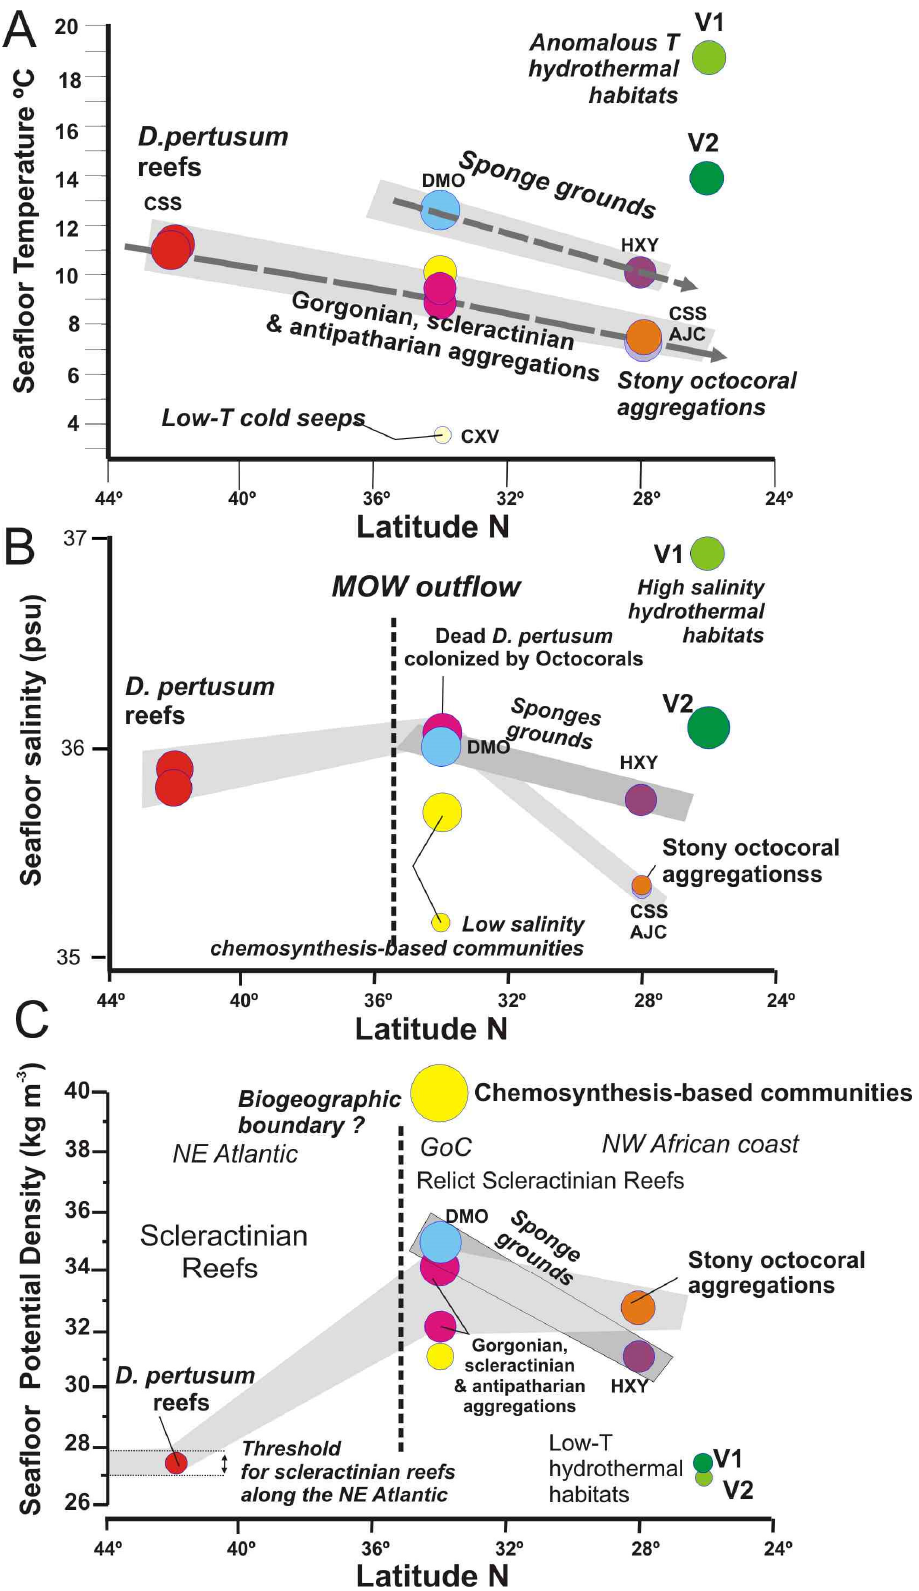
Figure 15. Seafloor water mass parameters vs. latitudes for each vulnerable deep-sea habitat detected in this study: ( A ) Temperature; ( B ) Salinity; and ( C ) Potential Density. Colour legend is the same as in Figure 13.